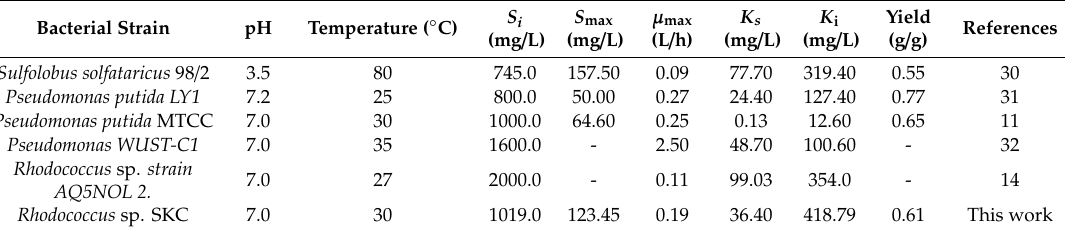
Table 2. Haldane model parameters of different bacteria reported previously.